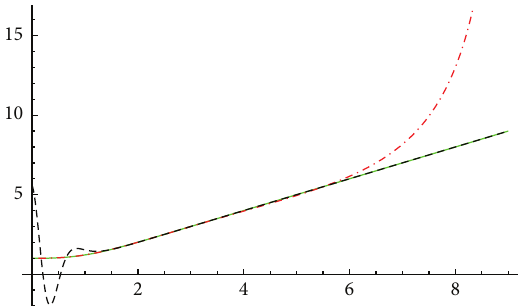
Figure 3: The near-field approximation 𝜙 20 (𝑥) (dot-dashed line), far-fieldapproximation 𝜑 3 (𝑥) (dashedline),andexactsolution 𝑢 ∗ (𝑥) (solid line).